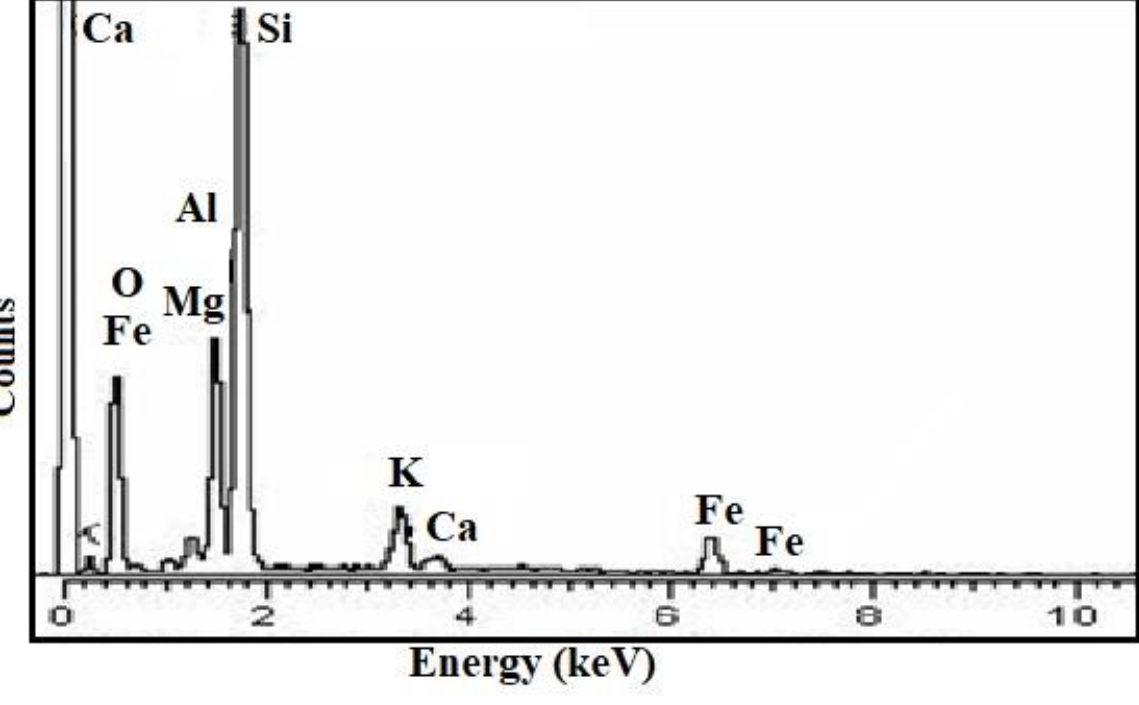
Figure 3. EDX of anthill catalyst